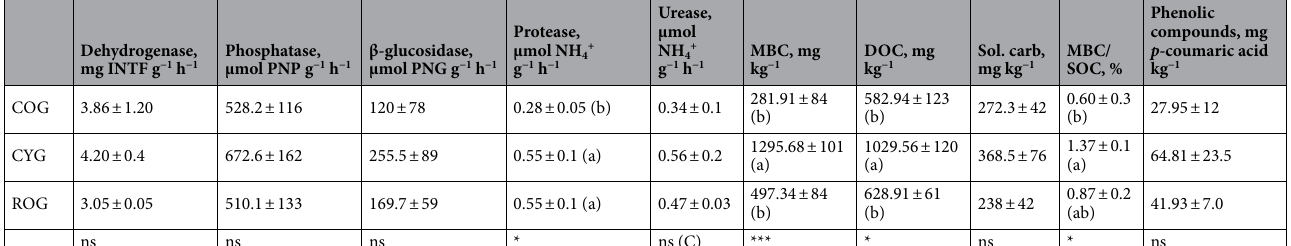
Table 3. Enzymatic activities, microbial biomass C and dissolved organic C of Lama Giulia soils (mean ± standard deviation of three replicates). COG control soil, CYG cypress soil, ROG Robinia pseudoacacia L. Soil, MBC microbial biomass carbon, DOC dissolved organic carbon, Sol. carb. soluble carbohydrates, SOC soil organic carbon. The values in each column followed by a different letter are significantly different according to HSD test or Friedman test (C). *Significant at p ≤ 0.05; ***significant at p ≤ 0.001; ns not